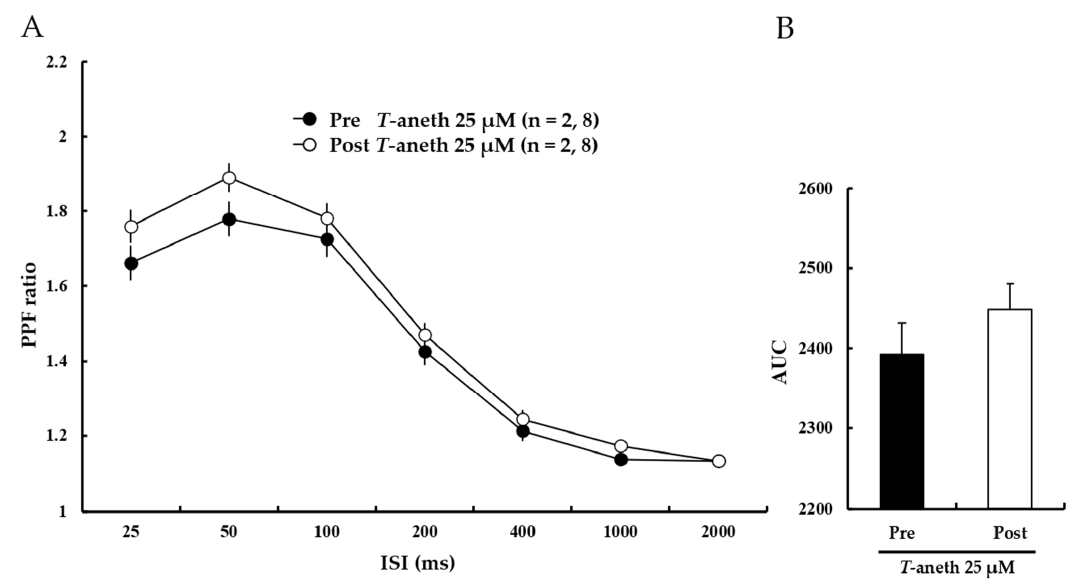
Figure 5. Anethole (25 µ M) treatment does not affect the PPF ratio. ( A ) Paired-pulse facilitation (PPF) ratios were similar before and after perfusion of anethole (25 µ M). Filled circles and open circles indicate the Pre-25 µ M Trans -anethole group and Post-25 µ M Trans -anethole group, respectively. ( B ) The areas under the curve (AUCs) for the PPF ratio did not significantly differ. Statistical significance (Post- Trans -anethole group vs. Pre- Trans -anethole group) was calculated by Student’s t -test. ISI: interstimulus interval, AUC: area under the curve. T -aneth: Trans -anethole.